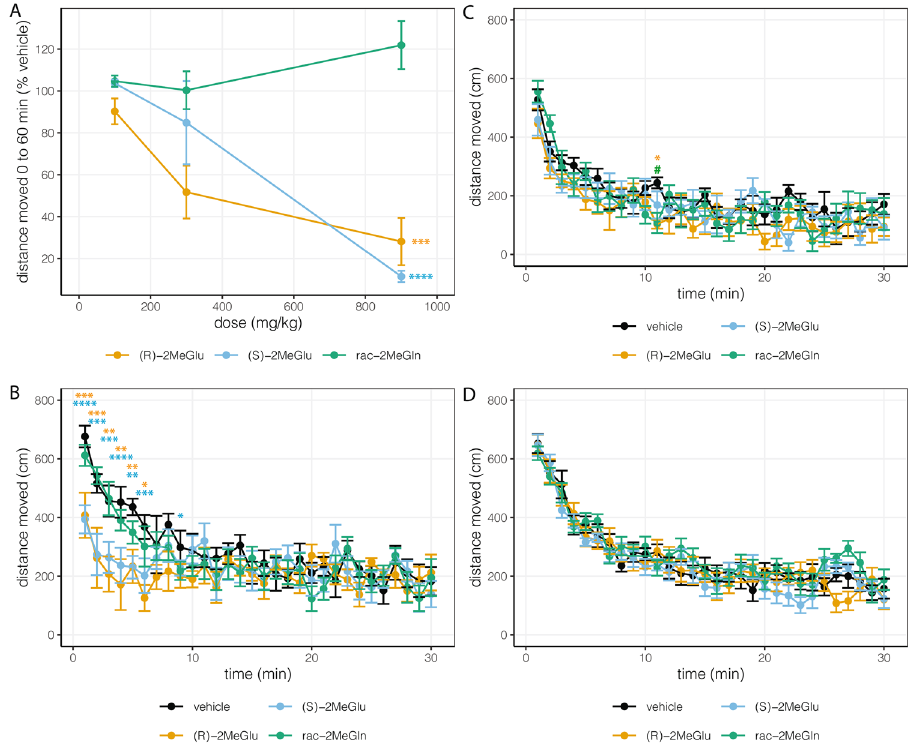
Figure 6. Exploratory and locomotor behavior in 2 month-old male C57Bl/6 mice was assessed by total distance moved in the novel cage test ( A ) or in the activity chamber ( B – D ). Mice were either injected and then immediately tested (acute groups in A – C ), or injected daily for one week prior to testing (chronic groups in D ). Data are shown as mean ± SEM. ( A ) Dose–response for each of the three compounds vs. total distance moved from 0 to 60 min in the novel cage test expressed as % of vehicle exposed mice (n = 3 mice per group). Two-way ANOVA had F Interaction (4, 18) = 9.068, P = 0.0003; F Dose (2, 18) = 14.91, P = 0.0002; and F Compound (2, 18) = 21.89, P < 0.0001. Tukey’s multiple comparison test was significantly different for rac-2MeGln vs. ( R )-2MeGlu (****P < 0.0001) and vs. ( S )-2MeGlu (***P = 0.0002). ( B ) Time course of activity chamber distance moved following acute 100 mg/kg had two-way repeated measures ANOVA with F Interaction (87, 580) = 1.879, P < 0.0001; F Time (29, 580) = 11.44, P < 0.0001; and F Exposure (3, 20) = 2.906, P = 0.0600 (n = 6 mice per group). Dunnett’s multiple comparisons test had multiple early time points that were significantly different between vehicle and ( R )-2MeGlu or between vehicle and ( S )-2MeGlu (*P < 0.05, **P < 0.01, ***P < 0.001, ****P < 0.0001); vehicle was not significantly different from rac-2MeGln at any time point. ( C ) Time course of activity chamber distance moved following acute 30 mg/kg had two-way repeated measures ANOVA with F Interaction (87, 580) = 0.9328, P = 0.6493; F Time (29, 580) = 20.13, P < 0.0001; and F Exposure (3, 20) = 1.805, P = 0.1786 (n = 6 mice per group). Dunnett’s multiple comparisons test had one time point that was significantly different between vehicle and ( R )- 2MeGlu (*P < 0.05) or between vehicle and rac-2MeGln ( # P < 0.05); vehicle was not significantly different from ( S )-2MeGlu at any time point. ( D ) Time course of activity chamber distance moved following chronic 10 mg/kg per day for one week had two-way repeated measures ANOVA with F Interaction (87, 986) = 1.22, P = 0.0912; F Time (29, 986) = 62.35, P < 0.0001; and F Exposure (3, 34) = 1.122, P = 0.3536; (n = 6 mice per group). One vehicle group mouse and one ( S )-2MeGlu group mouse were outliers using the ROUT method; they were removed from